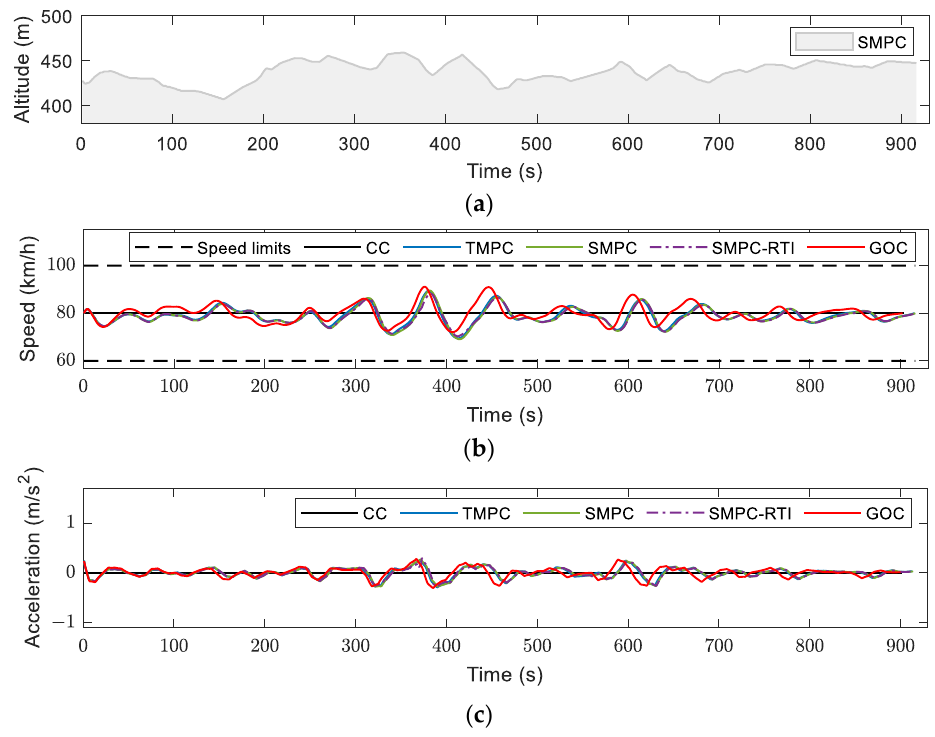
Figure 12. Road altitude and results on the motorway. ( a ) Road altitude against driving time in SMPC. ( b ) Vehicle speed results of different speed controllers. ( c ) Acceleration of different speed controllers.